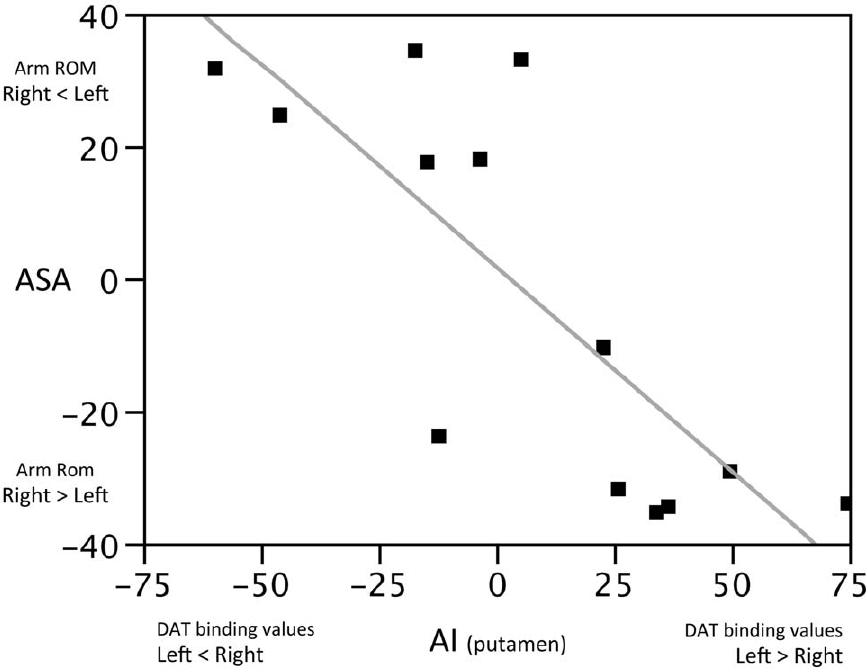
Figure 1. ASA significantly correlated to the AI of DAT binding values of the putamen (see, Methods).